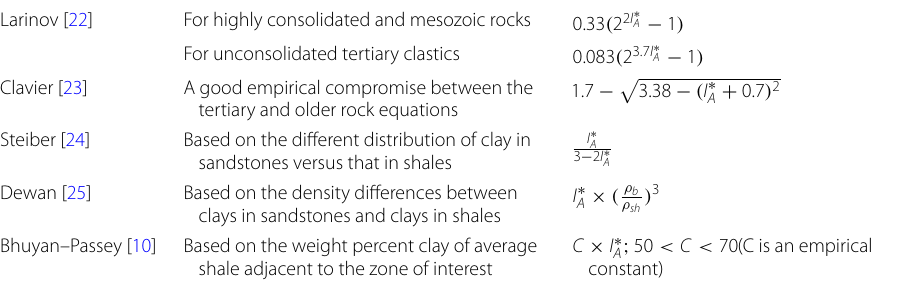
* I A is the gamma ray/potassium/thorium index obtained from the standardization of natural gamma ray log and/or its components data. The ρ b and ρ sh are the bulk density, and shale density, respectively